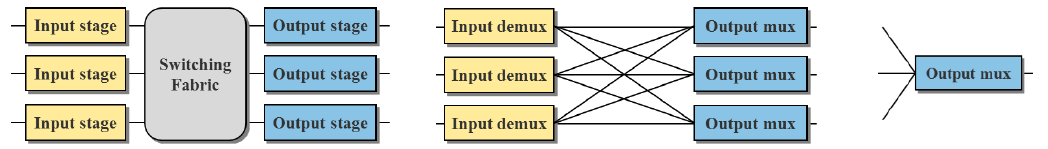
Figure 12. Basic structure of a packet switch ( left ); simplified to a demux–mux ( center ); and a separate output mux ( right ).